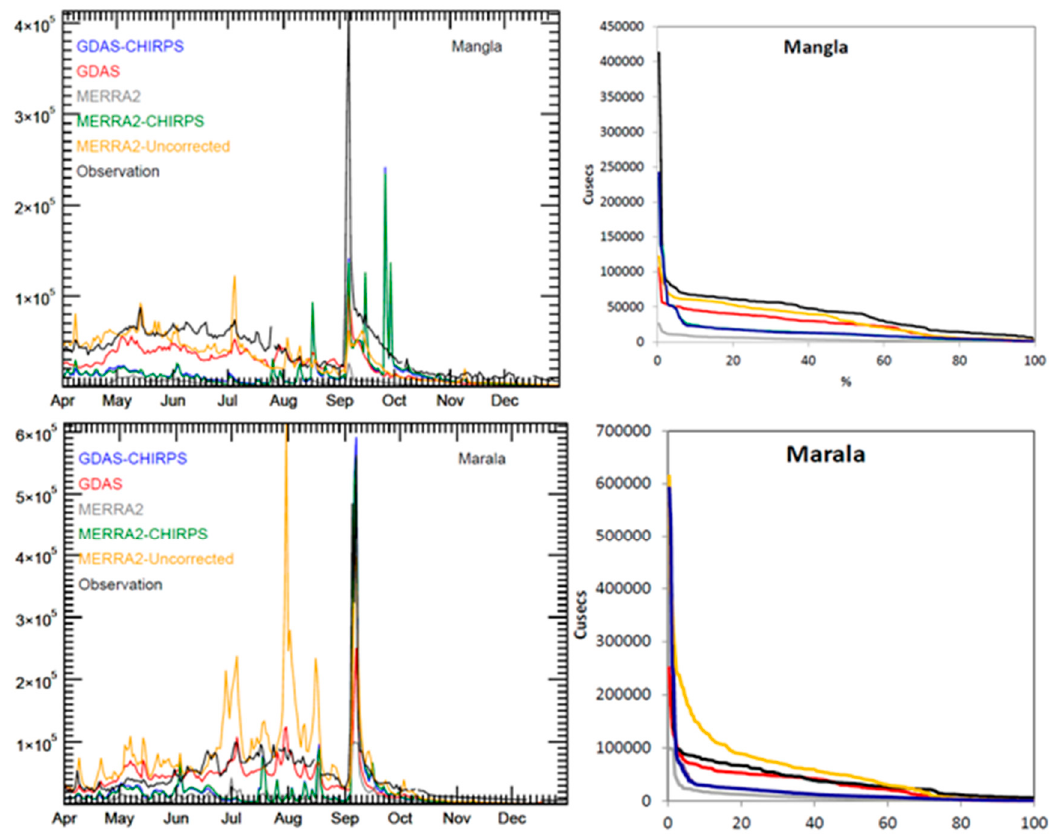
Figure 9. Same as in Figure 8 except for stations Mangla ( top ) and Marala ( bottom ).